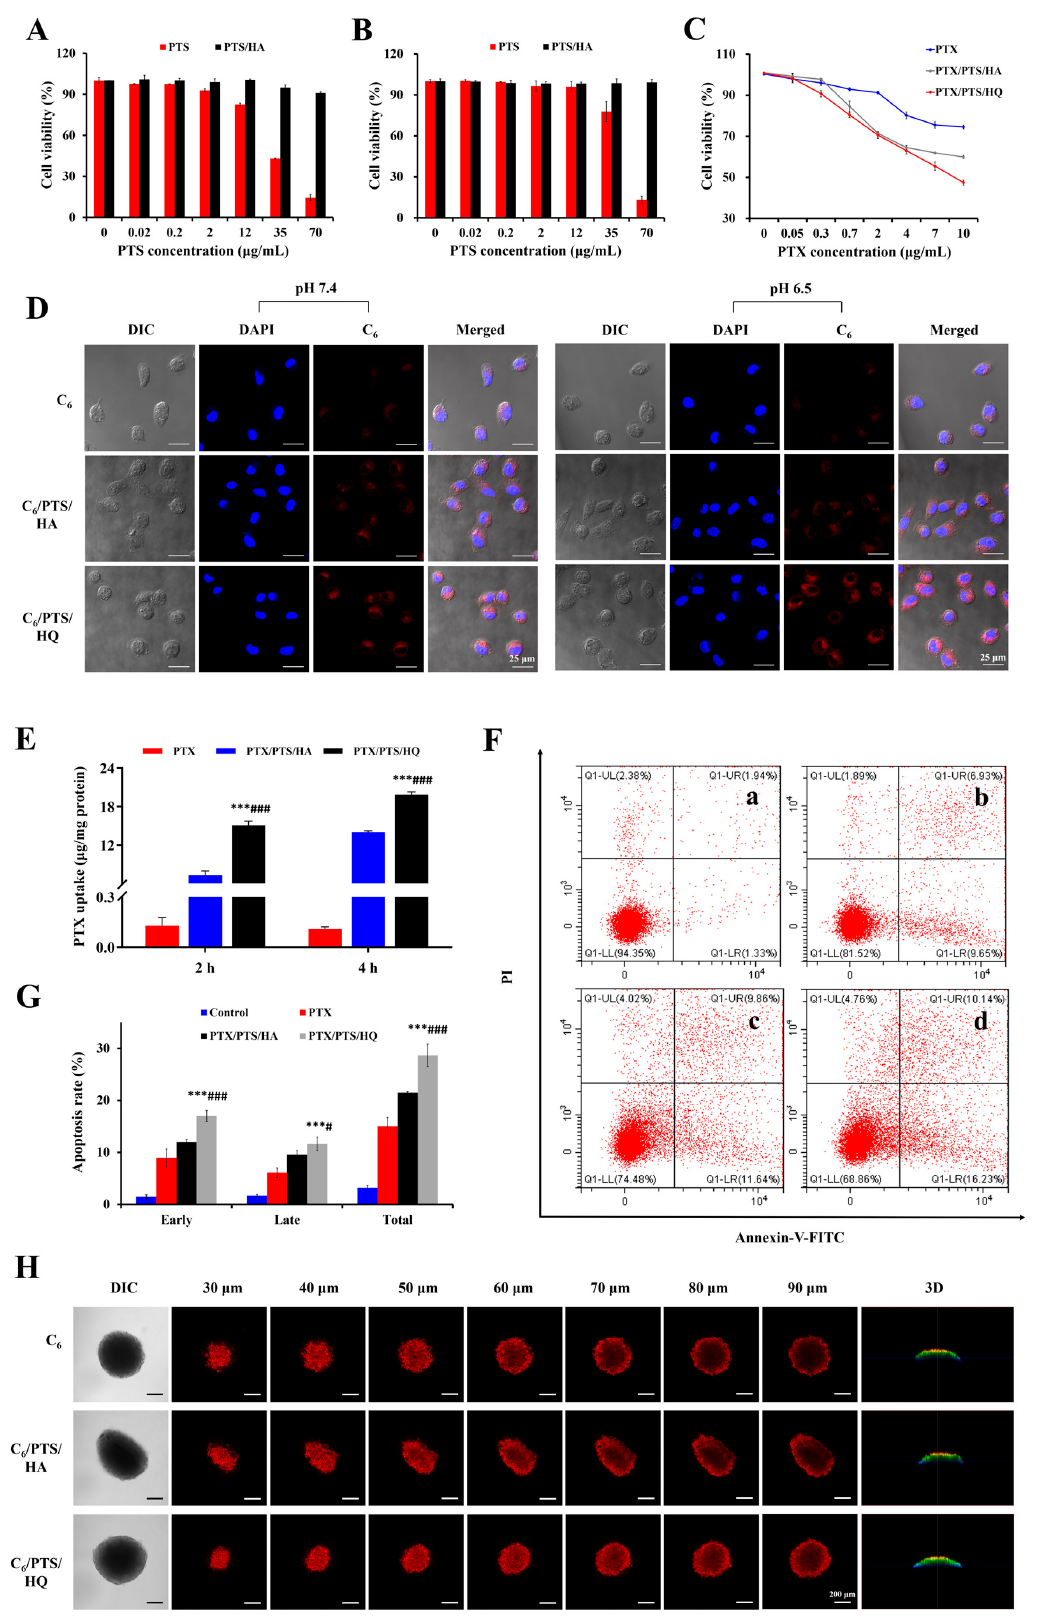
Figure 4. Cellular accumulation and in vitro antitumor therapeutic potential of PTX/PTS/HQ PNPs. Cell viabilities of ( A ) MDA-MB-231/DOX and ( B ) MCF-7/ADR cells incubated with PTS and